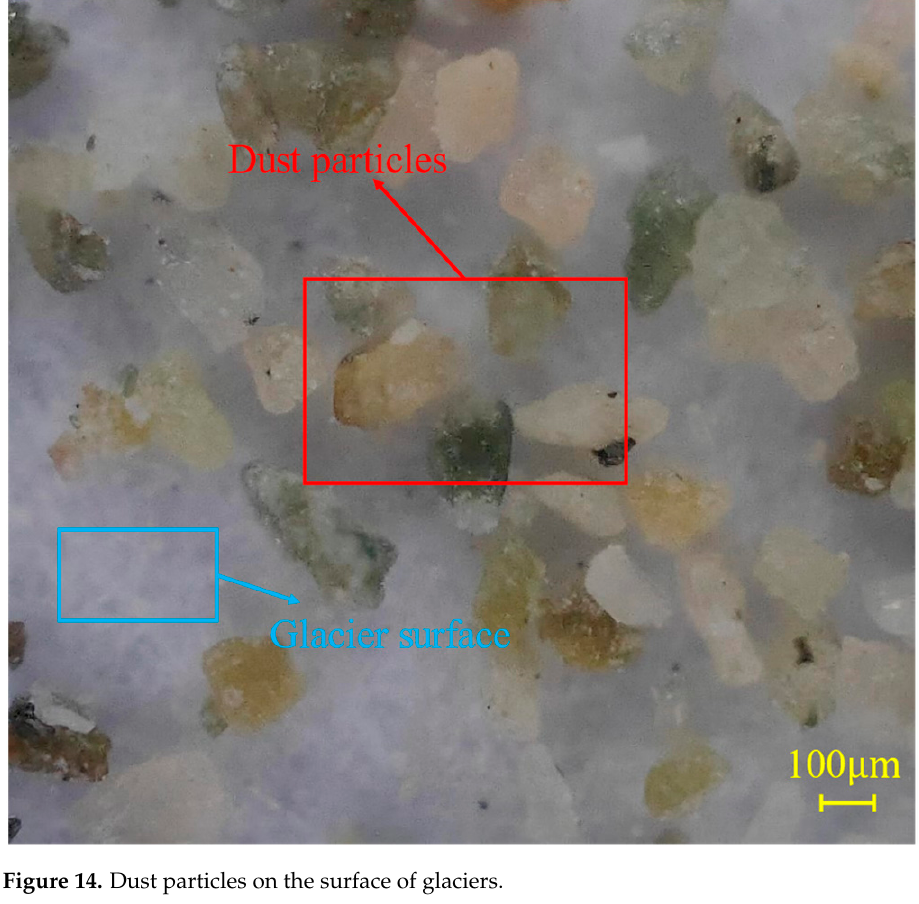
capacities and high thermal conductivities, with a greater capacity than snow and ice to absorb and release energy [40]. In addition, the minerals of the dust particles chemically react with oxygen and meltwater on the glacier surface, thereby releasing heat continu- ously and further accelerating the glacier melting [41]. Thus, the dust cover accelerates the glacier melting and affects the glacier mass balance, as shown in Figure 16. Figure 14. Dust particles on the surface of glaciers. Figure 14. Dust particles on the surface of glaciers.